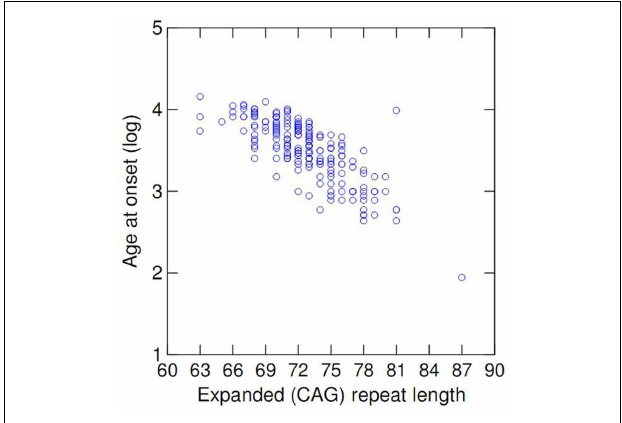
FIGURE 1 | Scatterplot of age at onset vs. length of expanded (CAG) repeat at ATXN3 .